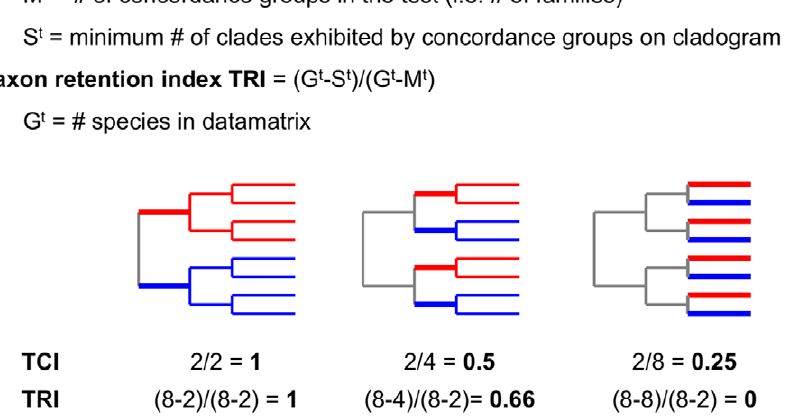
Figure 1. Assessing phylogenetic signal through taxonomic congruence. The equations used tocalculate the scores for two measures of phylogenetic signal through taxonomic congruence used in this study. Example calculations are shown for three cladograms each containing two concordance groups (M t =2), one red, one blue, with each group having 4 species (G t =8). In practice the scores can be calculated by coding membership in a concordance group as a character in a datamatrix and obtaining CI and RI values from PAUP.